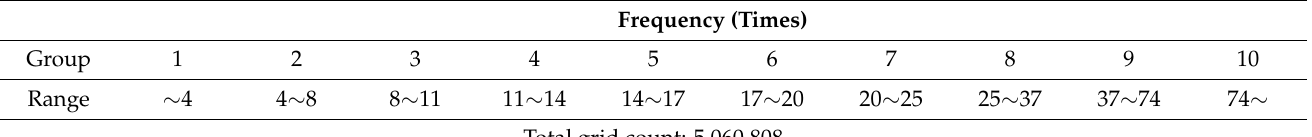
Table 7. Ship frequency classification among the 10 groups. Frequency